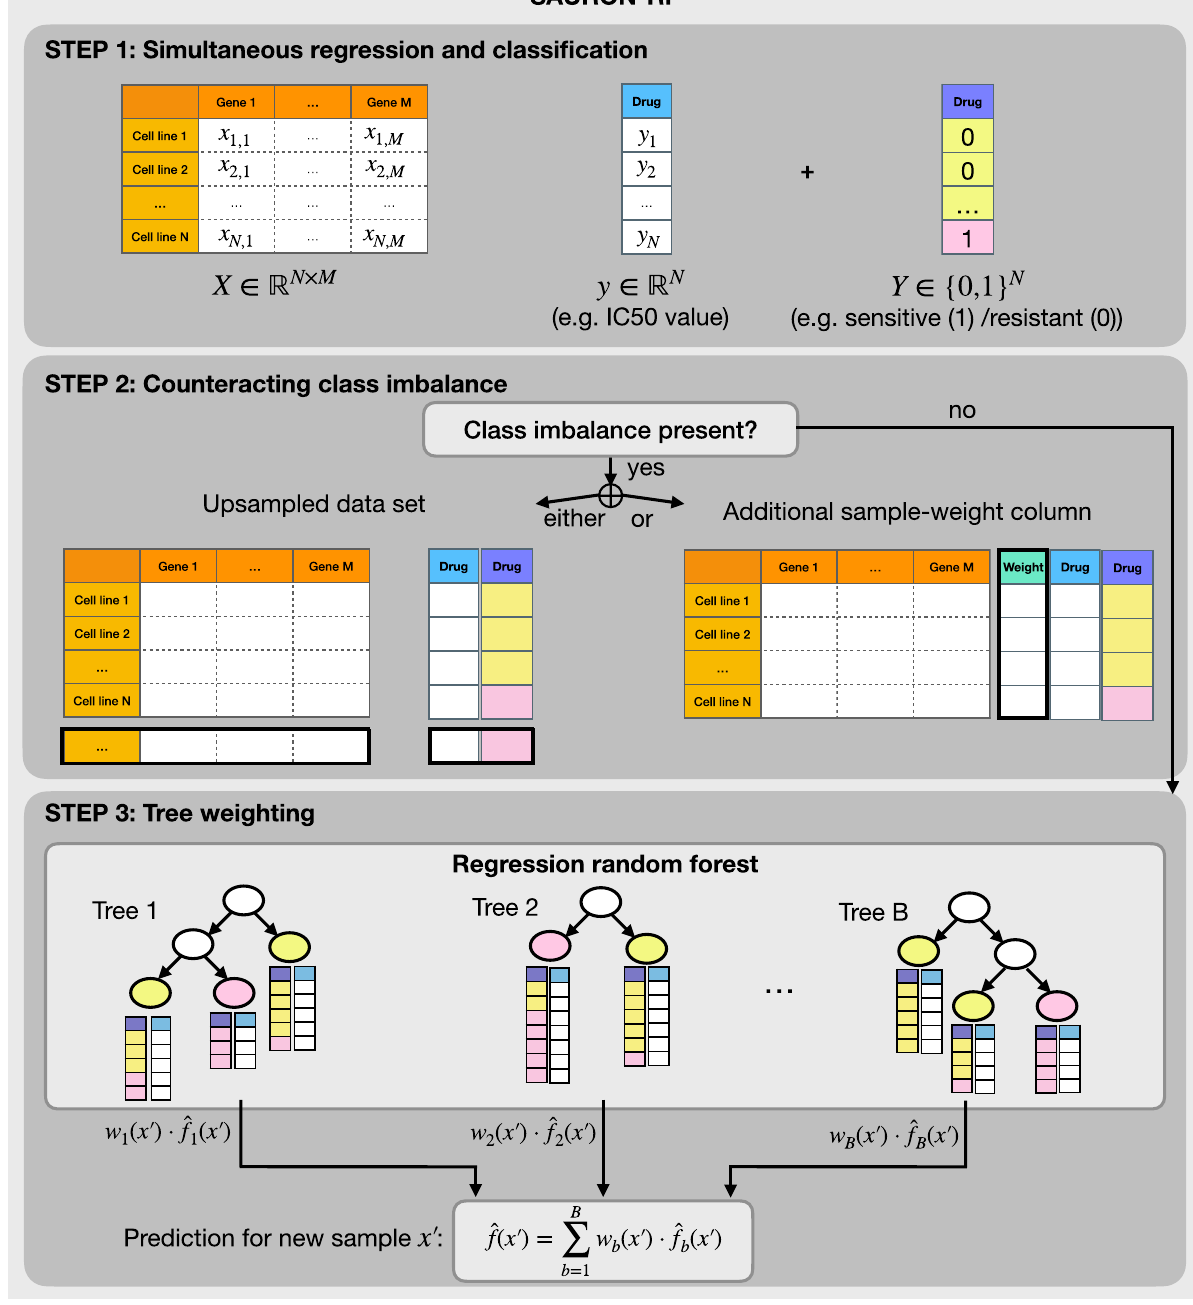
Figure 1. Workflow SAURON-RF. The figure depicts the three-step workflow of SAURON-RF. The SAURON-RF procedure starts with a preprocessing phase, in which the dimensionality of the input gene expression matrix is reduced, and the binary drug response (sensitive/resistant) is derived from the logarithmized IC50 values. In the second step, SAURON-RF addresses class imbalance by either performing upsampling or using sample-specific weights. In the last step, a regression random forest is trained from the given continuous IC50 values and the gene expression matrix. Then, each leaf node is assigned to the majority class of its corresponding samples. Thereby, the regression random forest can also be used to classify samples by ′ majority vote over the trees. For a new sample x , a continuous prediction is calculated by multiplying the tree- ˆ ′ ) f b ( x ′ ) specific weights w b ( x with the tree-specific predictions